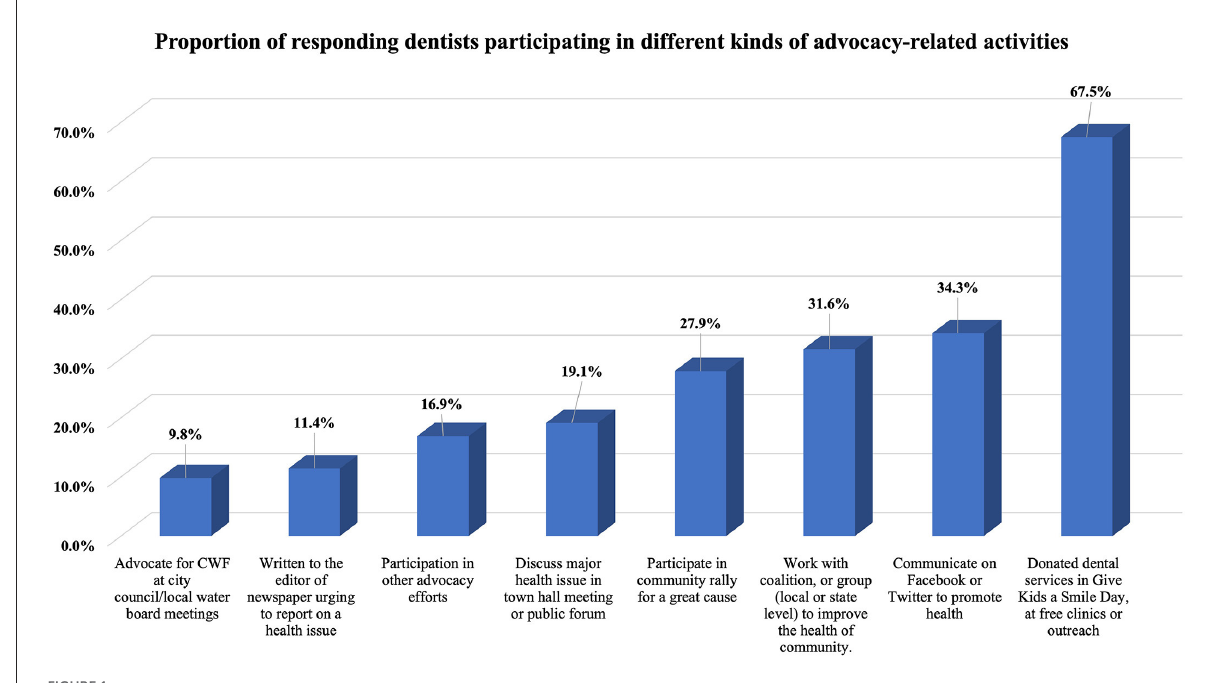
FIGURE1 Participation in different kinds of advocacy-related